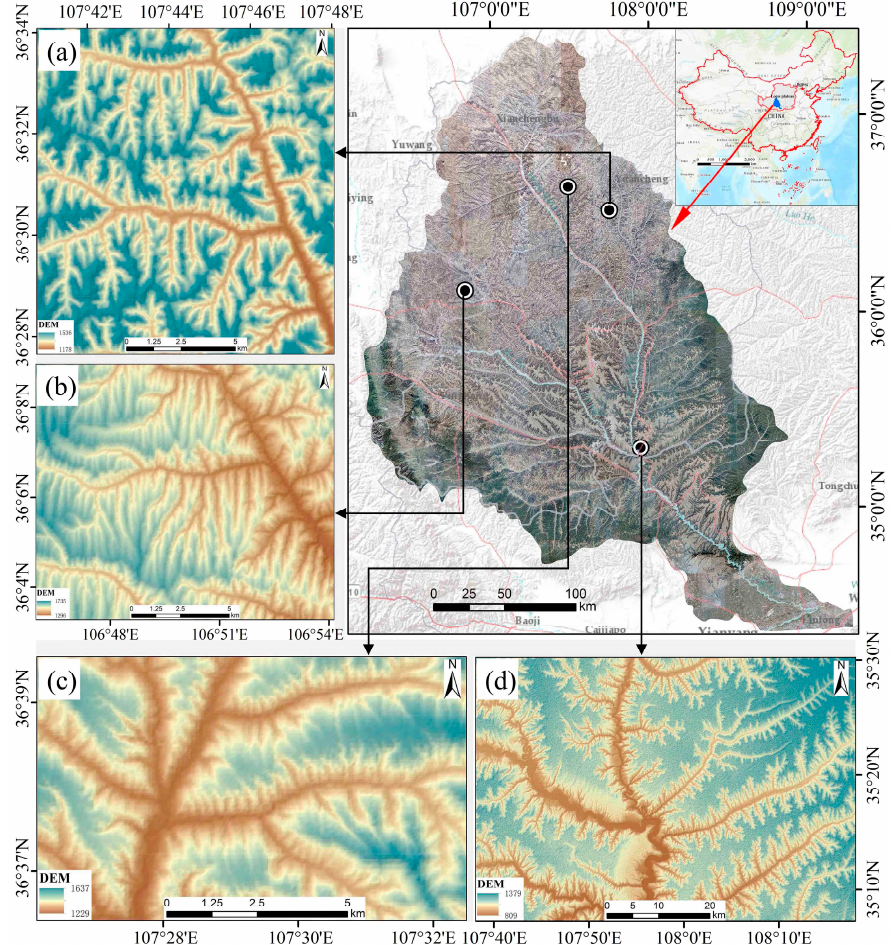
Figure 1. Location of study area and distribution of selected sample areas. ( a ) digital elevation model of the sample a; ( b ) digital elevation model of the sample b; ( c ) digital elevation model of the sample c; ( d ) digital elevation model of the sample